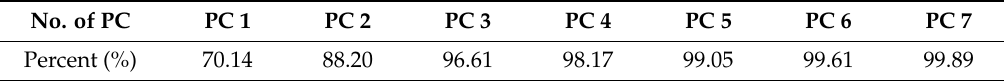
Table 2. Cumulative contribution rate of seven principal components.